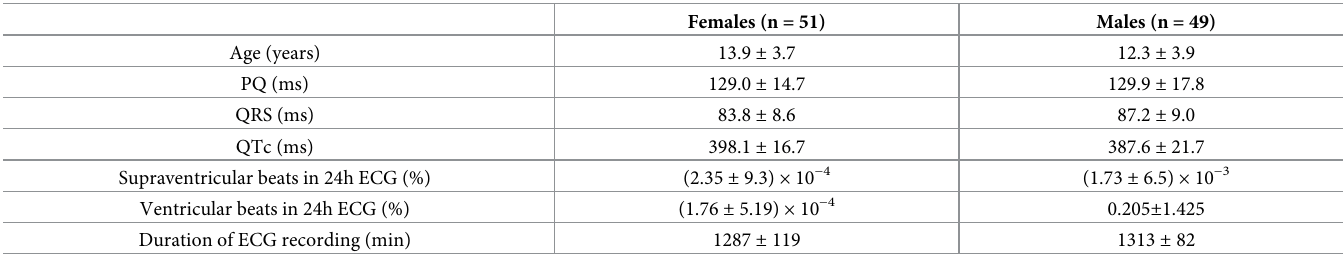
Table 4. Clinical characteristics of the population used in